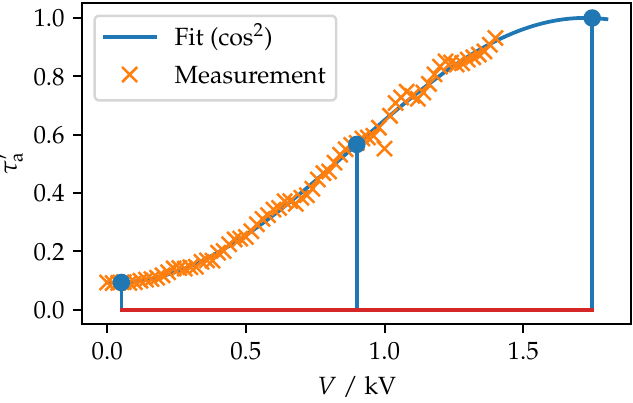
Figure 5. Normalized transmission τ (cid:48) a of MZM dependent on applied Voltage V . The half-wave voltage V λ /2 corresponds to the difference between the applied voltage at minimum transmission (left blue marker) and the applied voltage at maximum transmis- sion (right blue marker). The so-called quadrature point (middle blue marker) is exactly in between the two points of maximum and minimum transmission. It is often used as the preferred operating point of the MZM in bias voltage control algorithms. The half-wave voltage, according to a cos 2 fit, turns out to